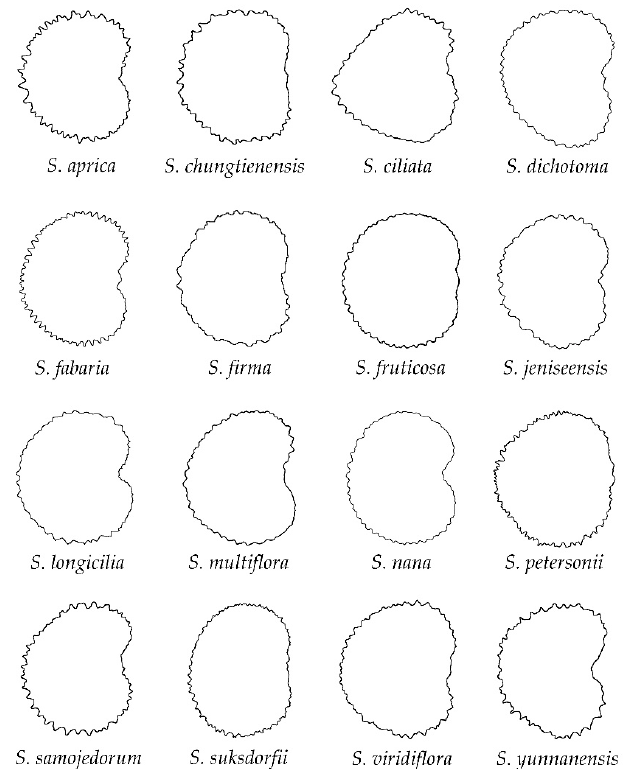
Figure 5. Silhouettes of the lateral view of seeds in the group of echinate outline.